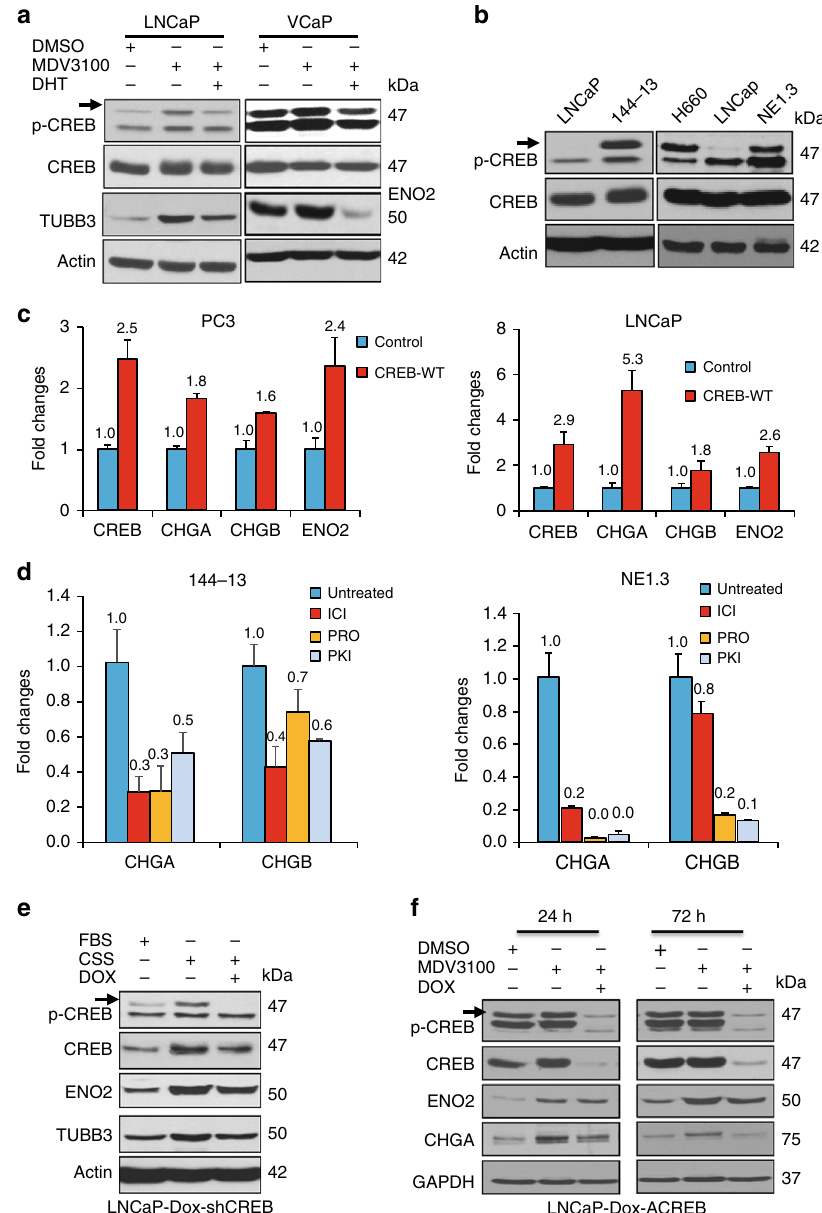
Fig. 1 Induced by ADT, CREB activation is critical for neuroendocrine phenotype of NEPC cells. a Western blotting for p-CREB (S133, activated) and NE markers ENO2 and TUBB3 in AR-positive LNCaP and VCaP cells treated with 10 μ M ADT drug MDV3100 (enzalutamide) for 72 h, without or with androgen 5 nM DHT during the last 24 h before cell lysate was collected. The upper band in p-CREB western blots is pS133-CREB and the lower band is p- ATF1. b Western blotting for CREB activation level (p-CREB) in NEPC NE1.3, NCI-H660, and 144-13 cells, as compared to LNCaP cells. c RT-qPCR for NE markers CHGA, CHGB, and ENO2 in prostate cancer cells overexpressing CREB wild-type (WT) cDNA. Y -axis shows relative fold changes in expression, normalized to GAPDH. d RT-qPCR for NE markers CHGA and CHGB in NEPC 144-13 and NE1.3 cells treated with Protein Kinase A inhibitor PKI (10 μ M), beta adrenergic antagonists ICI (10 μ M) or propranolol (PRO, 10 μ M) for 48 h. Error bars in PCR results represent standard deviation (s.d.) of triplicate experiments. e LNCaP cells carrying Dox-inducible-shCREB were grown in regular FBS medium, or CSS medium without or with 1 μ g ml − 1 of Dox for 6 days, followed by western blotting. f LNCaP cells carrying Dox-inducible ACREB (encoding a CREB inhibitory peptide) were treated with DMSO, 10 μ